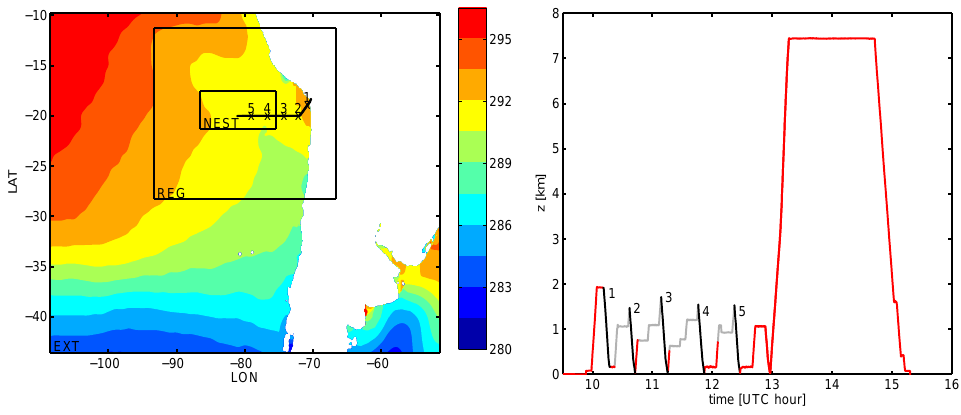
Fig. 1. Aircraft track for the flight B420. Left panel: WRF domains and geographical position of the aircraft together with the SST (colors). Right panel: aircraft altitude versus time for the track shown in the left panel; black lines – profiles used for model evaluation, gray lines – additional segments used to document the lower-tropospheric variability within the observed system.